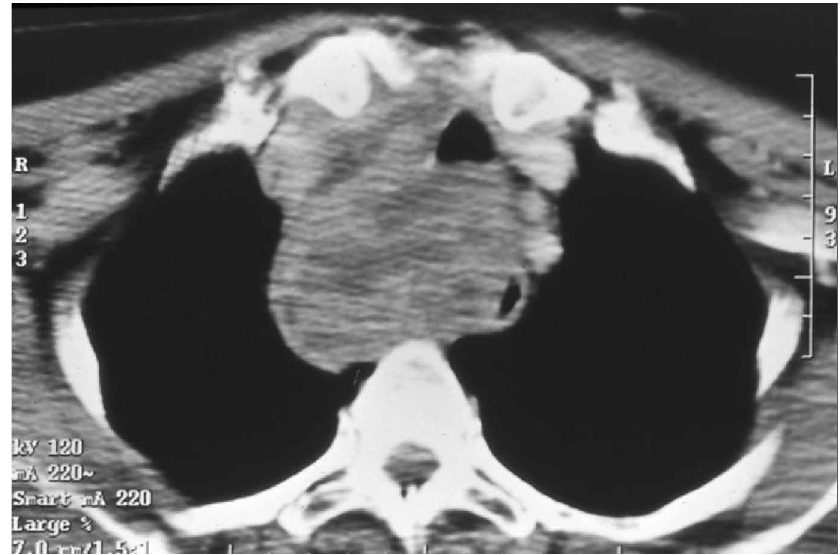
Fig. 1. Computerised tomography scan showing a mixed attenuation soft tissue mass within the right lobe of the